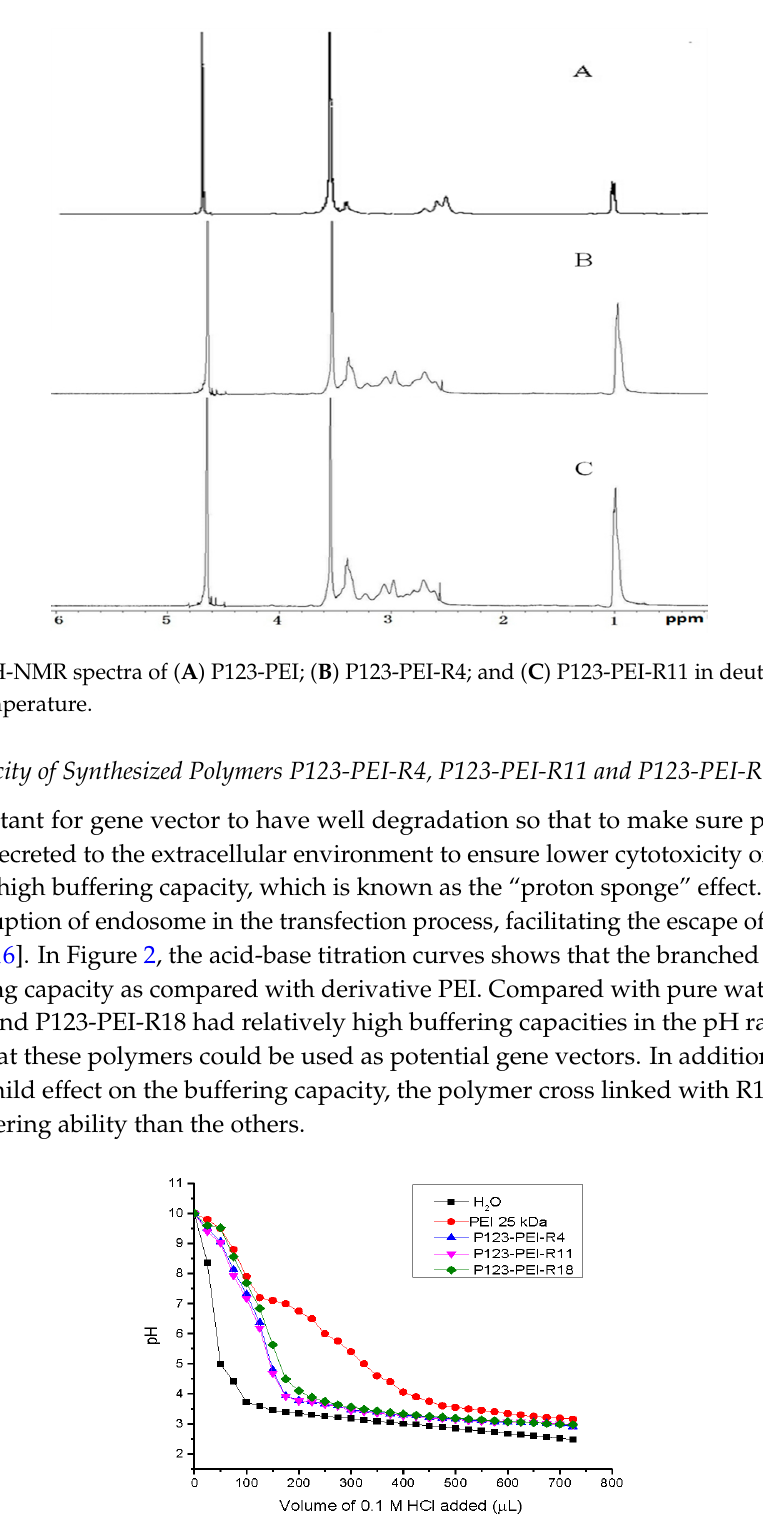
Figure 2. Determination of the buffering capacity of PEI 25 kDa, P123-PEI-R4, P123-PEI-R11